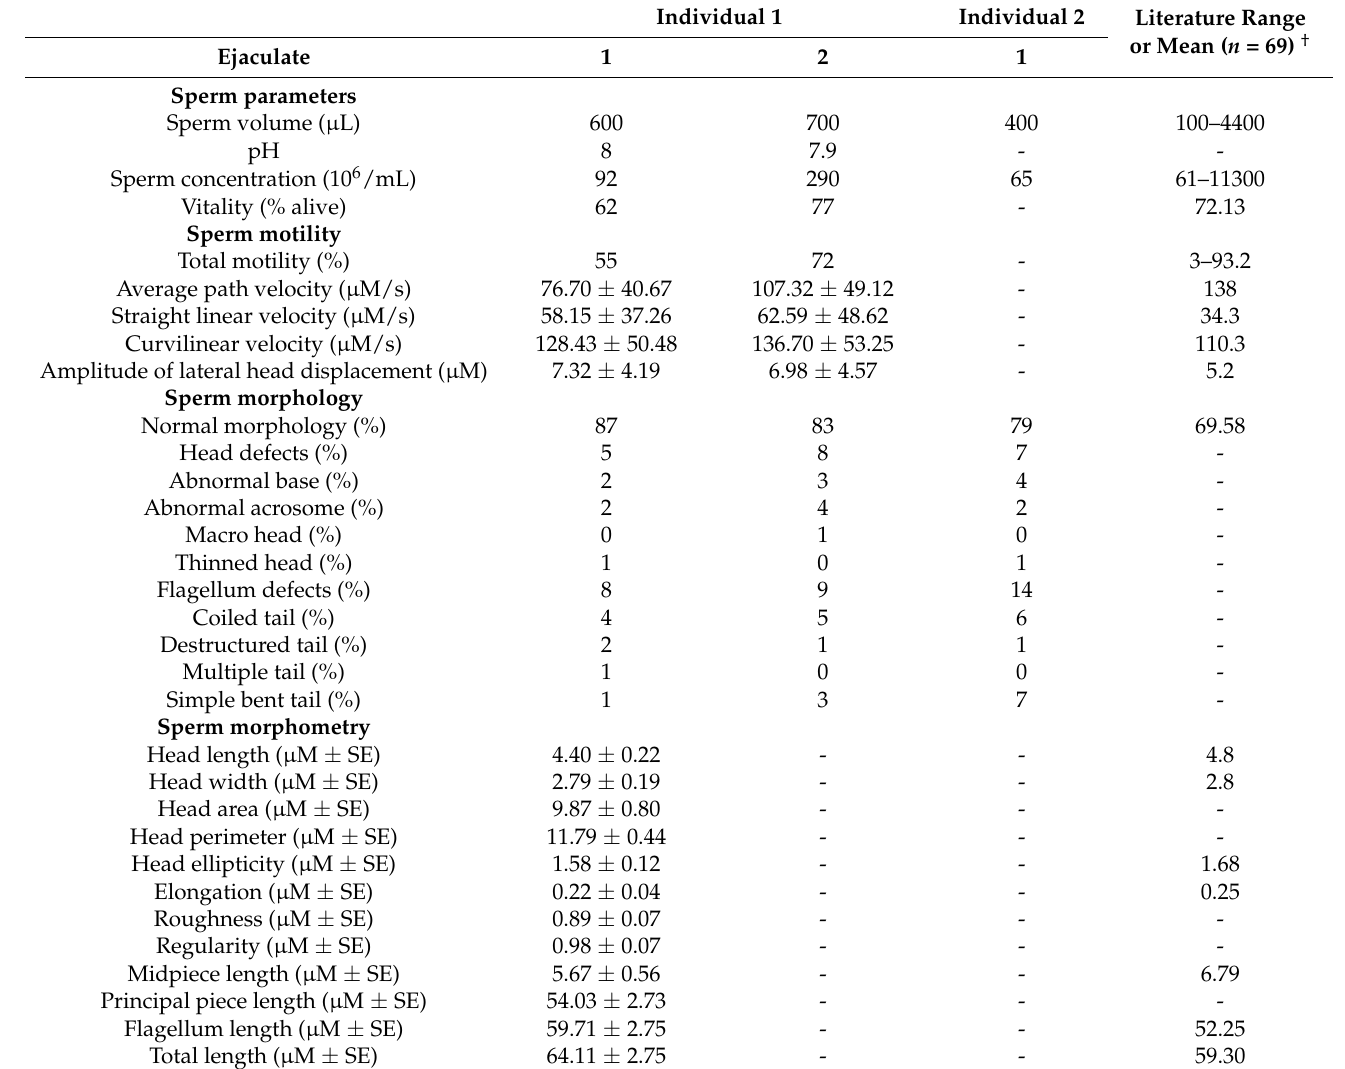
Table 1. Sperm parameters of both chimpanzees †